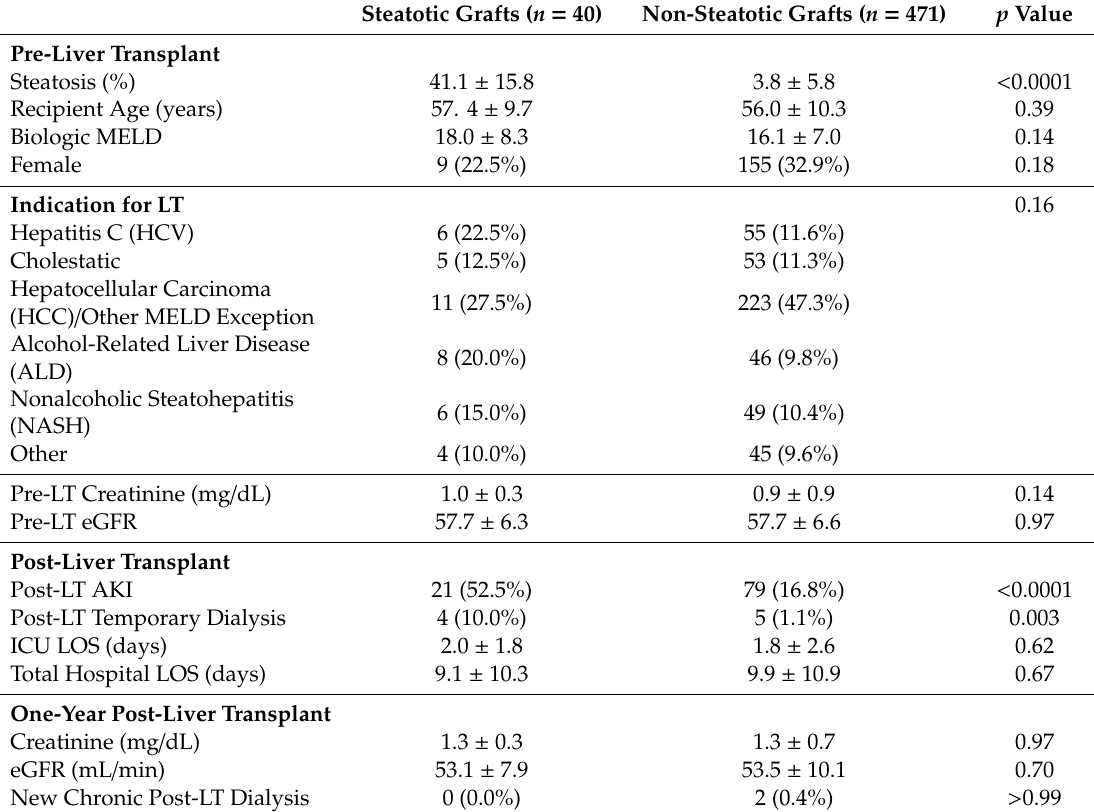
Table 1. Pre- and Post-Liver Transplant Recipient